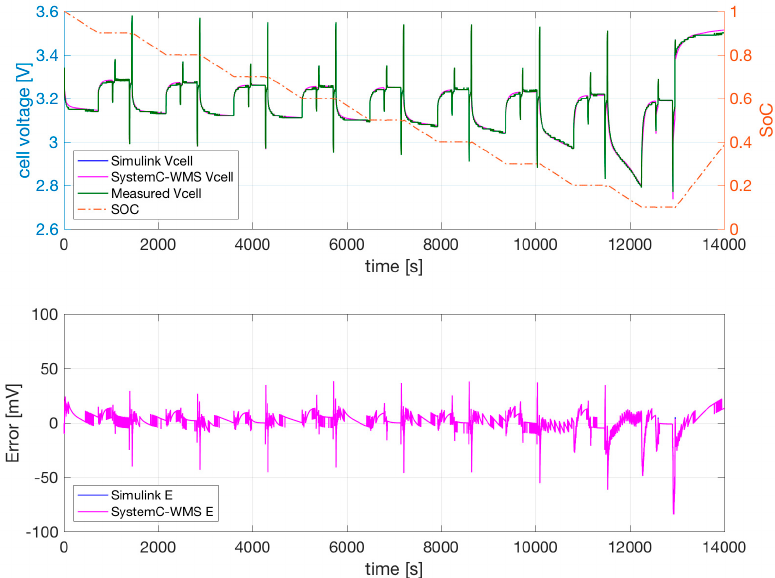
Figure 7. Measured voltage, SoC, SystemC-WMS, and Simulink simulations of the model shown in Figure 1b with parameters obtained with the extraction procedure and optimization at T = 0 °C. The lower part of this figure shows the error between SystemC-WMS and measurements and between Simulink and measurements.